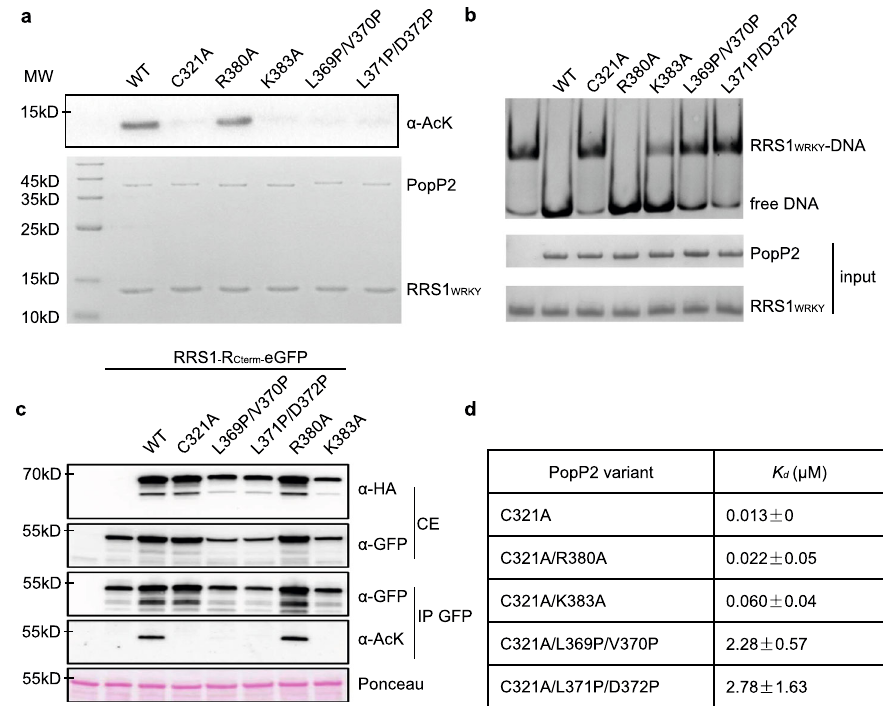
Fig. 4 InsP6 regulates RRS1 WRKY binding via the fold switch of PopP2. a In vitro acetylation assay of PopP2 variants in the presence of InsP6 and AcCoA, with RRS1 WRKY as substrate. This experiment was performed twice with similar results. The protein amount is indicated by Coomassie blue staining (bottom). b Electrophoretic mobility shift assay of PopP2 variants in the presence of InsP6, AcCoA, and W-box DNA, with RRS1 WRKY as substrate. Only unacetylated RRS1 WRKY proteins form complex with W-box DNA. The protein – DNA complexes and free DNA were detected by ethidium bromide (top), and the protein amount is indicated by Coomassie blue staining (bottom). c Immuno-detection of acetylated RRS1-R C-terminal portion in planta in the presence of WT PopP2 and PopP2-R380A mutant. Transient expression of 3HA-tagged PopP2 variants and eGFP-tagged RRS1-R Cterm were performed in N. benthamiana leaves, with samples harvested at 48 hpi. Detection of HA- and eGFP-tagged proteins was conducted using anti-HA and anti-GFP antibodies, respectively. Ponceau S staining of total proteins indicates equal loading of the samples. This experiment was conducted three times with similar results. d Binding analysis results of WT and PopP2 variants. The K d represents the mean value of two independent